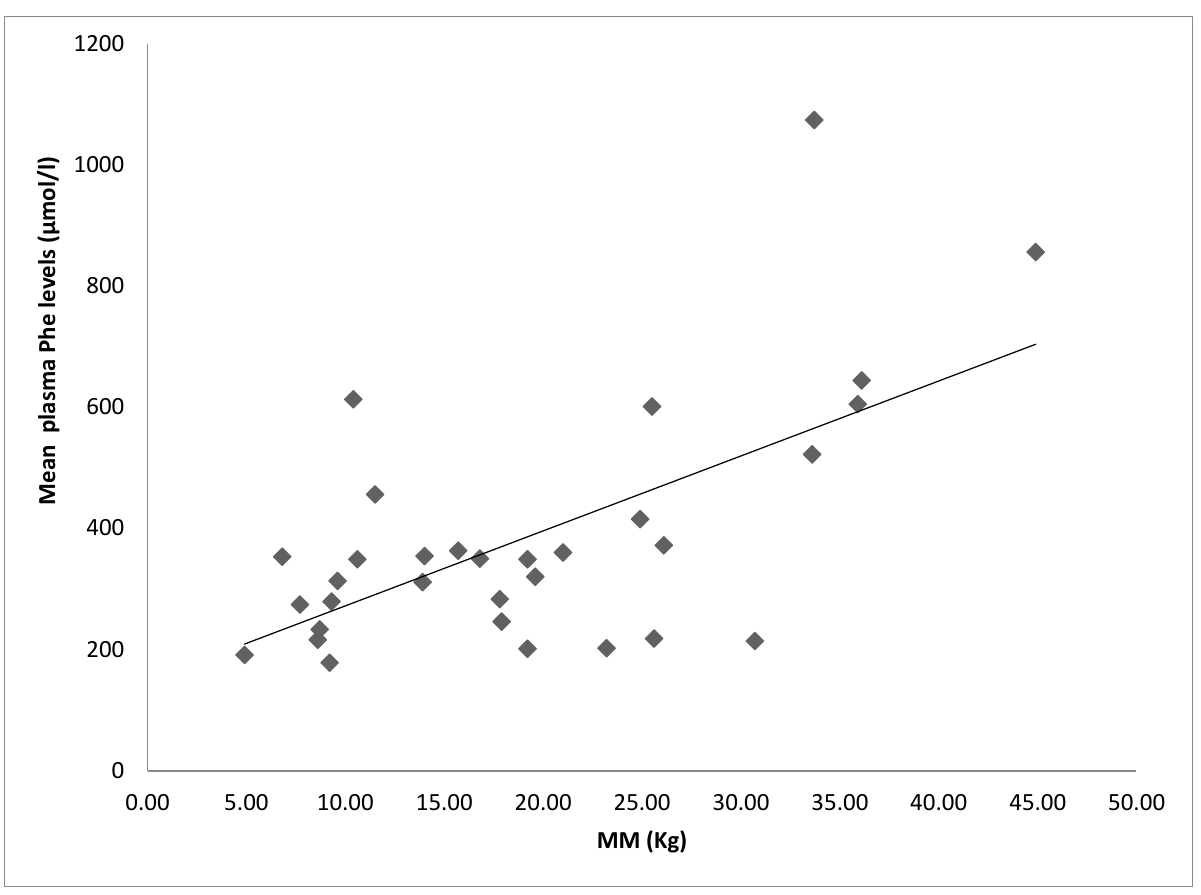
Figure 2. Correlation between mean plasma Phe levels and muscle mass (MM). r = 0.63 p < 0.001; Analysis only possible for 32 out of 36 patients because of missing BIA values.